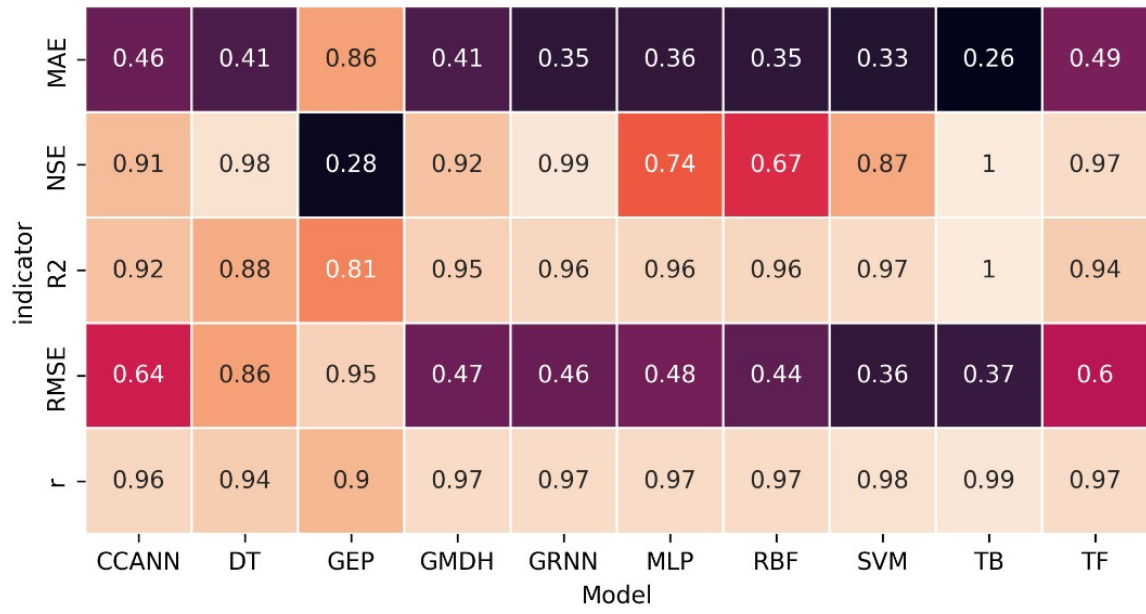
Figure 10. Selection of Best ML model through a heatmap diagram.